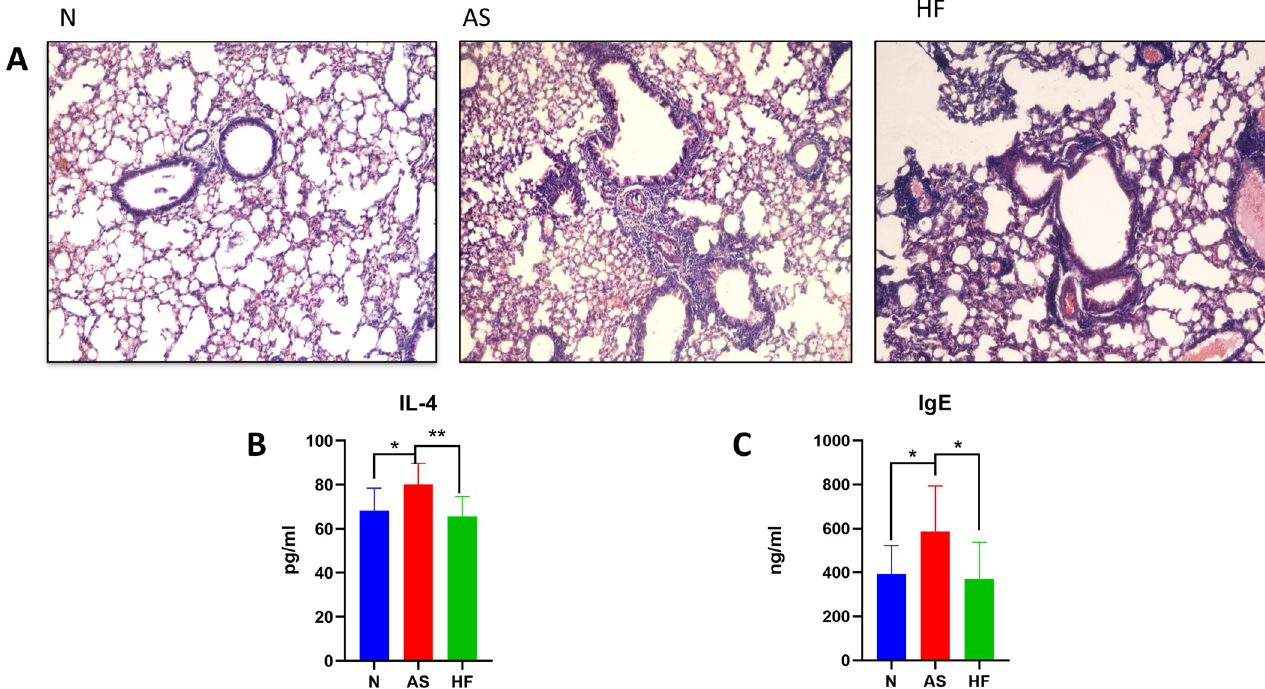
Fig 1. High-fiber diet can reduce lung inflammation and related cytokine production. A: The pulmonary inflammation in the AS group was significantly worse than that in the N group, but the situation was alleviated in the HF group. B: The IL-4 level in the AS group was significantly higher than that in the N group (P < 0.05), while the IL-4 level in the HF group was significantly reduced (P < 0.01). C: The IgE level in the AS group was higher than that in the N group (P < 0.05), while the IL-4 level in the HF group was significantly reduced (P < 0.05).